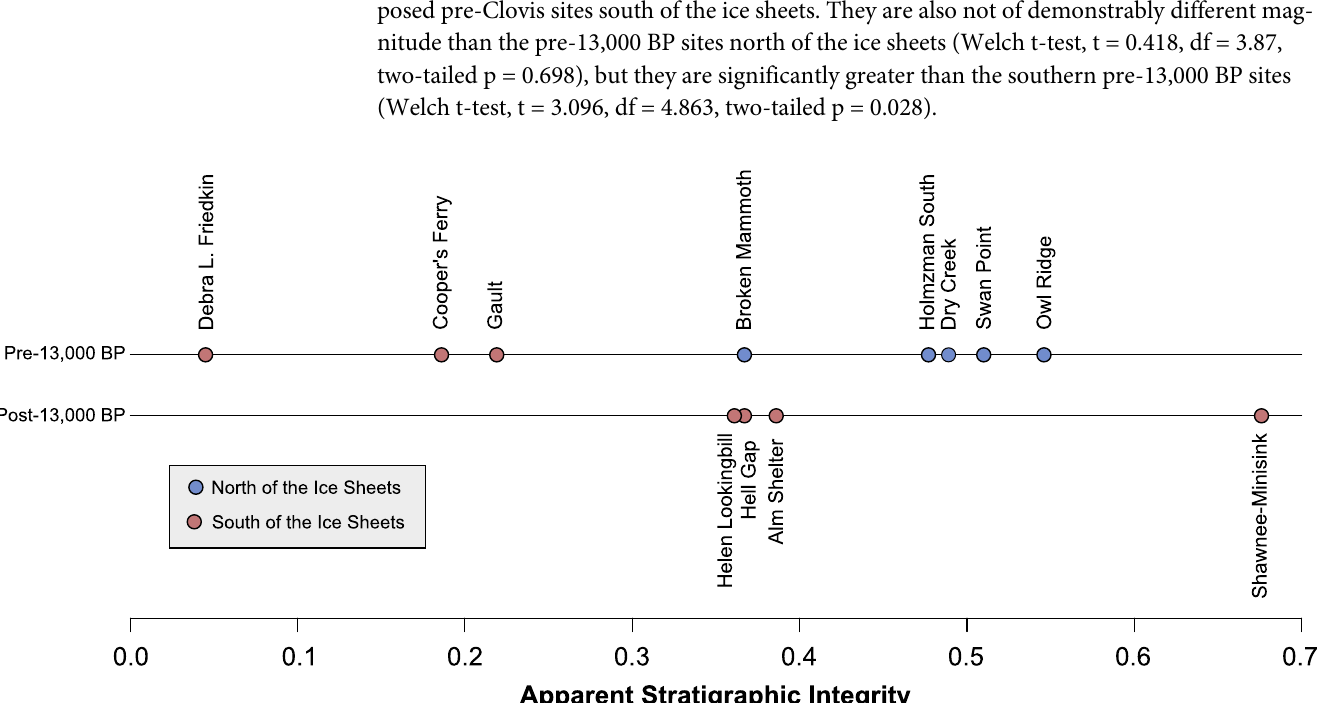
Fig 6. ASI values for all pre- and post-13,000 BP sites in the study.